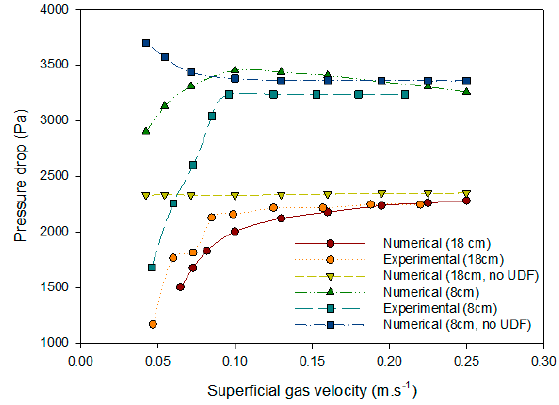
Figure 6. Experimental and numerical pressure drop curves comparison for the 75 kW th reactor measured at 8 cm height and at 18 cm height from the distributor plate.